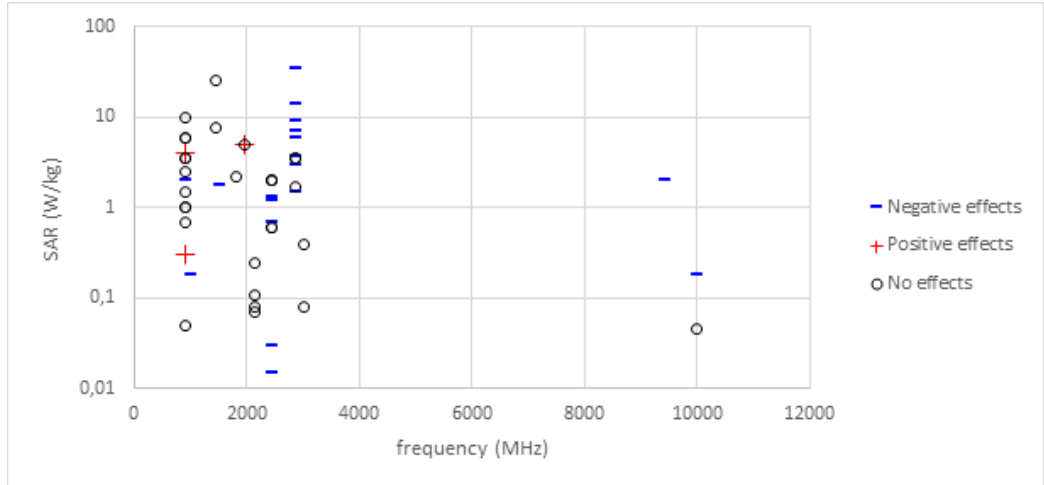
Figure 1. Diagram showing the exposures and RF frequencies used by the studies listed in Tables 1–3, irrespective of behavioural task or species. Exposures are expressed as whole-body specific energy absorption rate (SAR) in W / kg. Studies are shown as either having a detrimental e ff ect on behaviour (Negative studies) a beneficial e ff ect (Positive e ff ect) or not having a significant e ff ect on